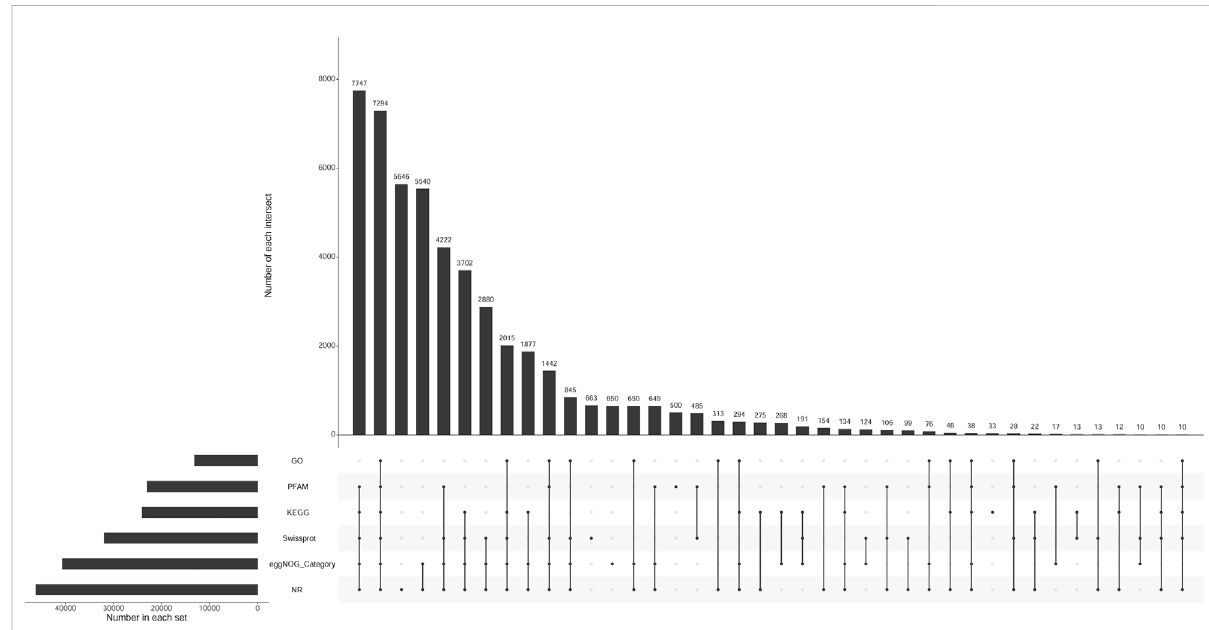
FIGURE 1 The upset chart ofunigenesannotation.Note: Numberin each setrepresents the number of all unigenes annotated to each database. Number ofeachintersectionrepresentsthenumberofcommonunigenesannotatedbymultipledatabases.Apointontheabscissarepresentsthenumberof unique unigenes annotated by each database. The multiple point connection on the abscissa represents the number of common unigenes annotated by multiple databases which were